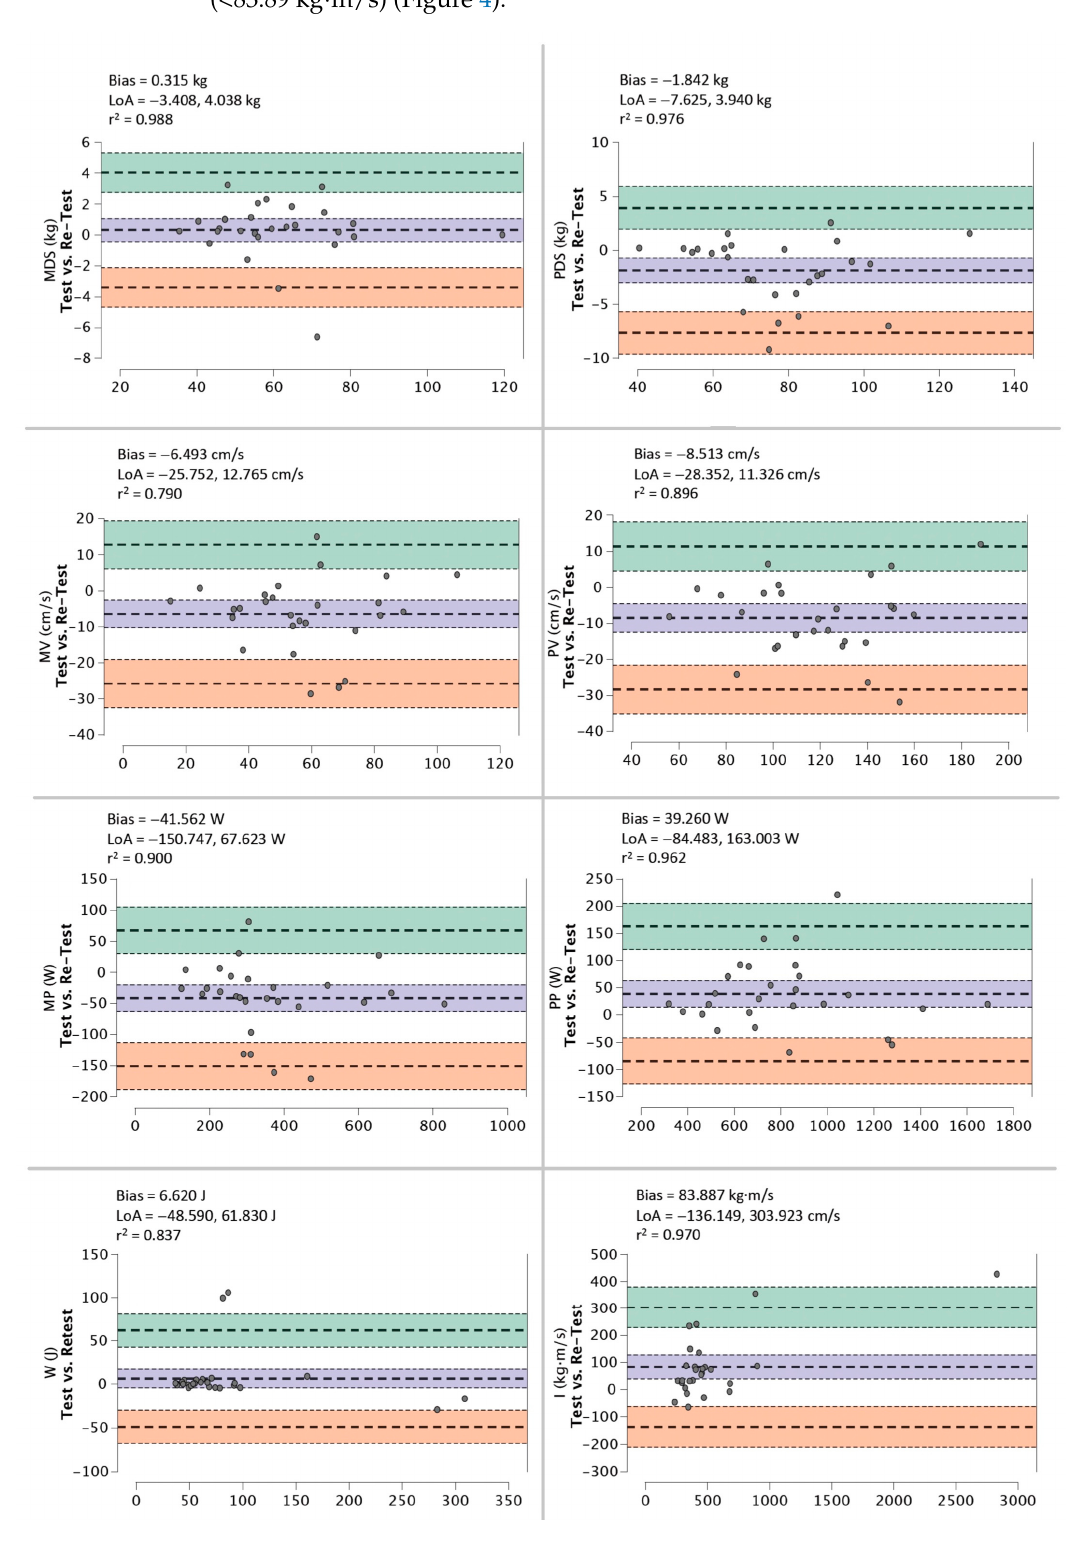
Figure 4. Bland-Altman plots of test–retest for MDS, PDS, MV, PV, MP, PP, W, and I during 75% 1RM protocol using a DEMF.